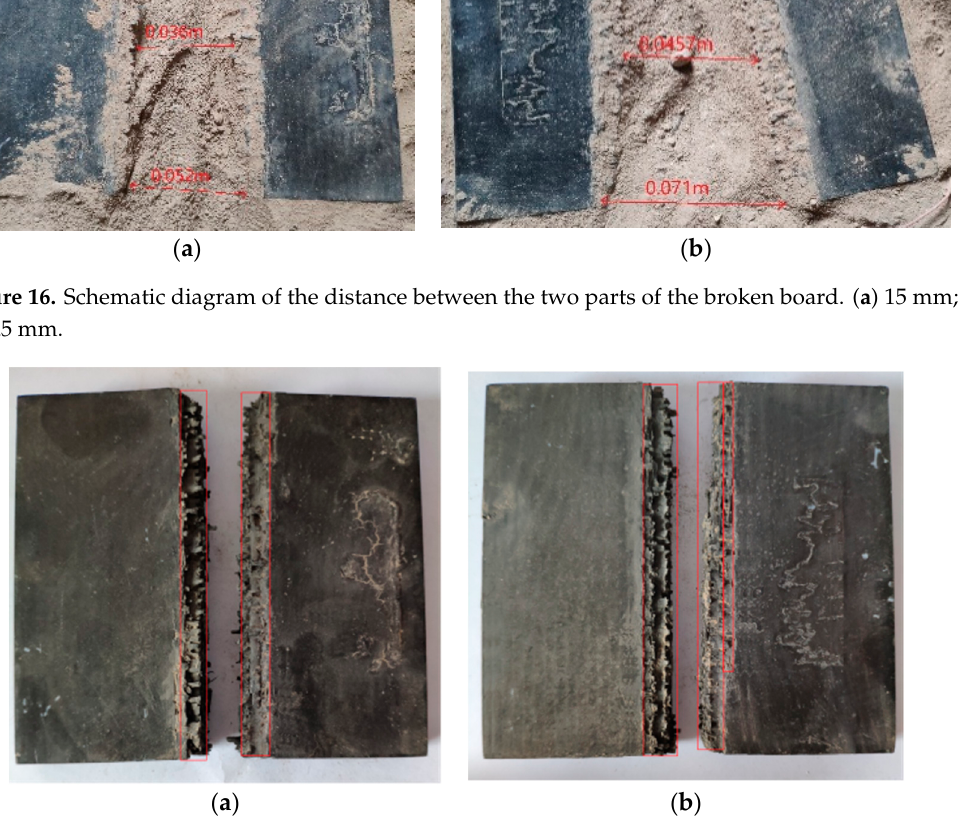
Figure 16. Schematic diagram of the distance between the two parts of the broken board. ( a ) 15 mm; ( b ) 25 mm.